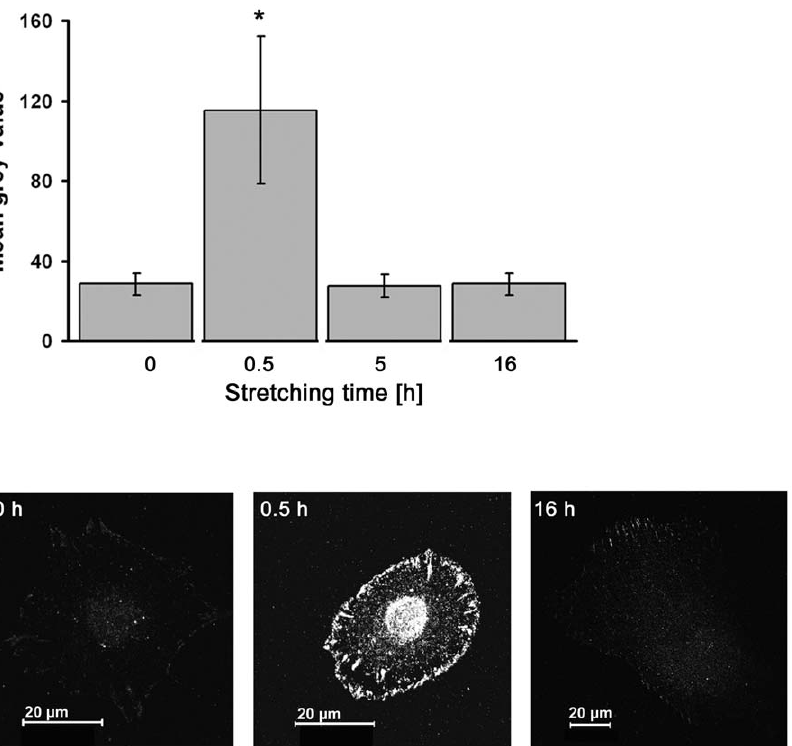
Figure 7. Tyrosine phosphorylation during stretch application. Cells were cyclically stretched with amplitude a 3 (11.8%) and immunofluorescently stained for phospho-tyrosine after indicated durations. All time points were stained simultaneously. Mean grey values are given. n=50 focal adhesions from 5 to 6 different cells. Asterisk=significantly different to initial values (0 h) (P # 0.05). Typical images analyzed for phospho-tyrosine staining of FAs are indicated below the graph. Here, microscope settings were kept identical for all images and show therefore basically no phosphorylation at time points 0 h and 16 h.